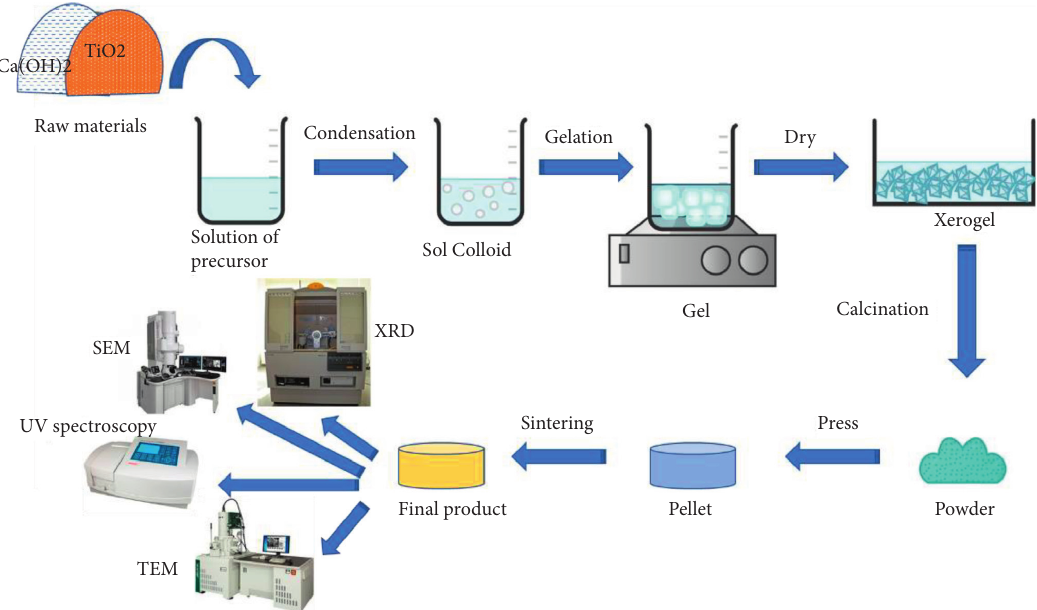
Figure 3: Block diagram of the sol-gel preparation method. Table 1: Crystal size values derived using the average Scherrer, Scherrer straight line, and Williamson–Hall